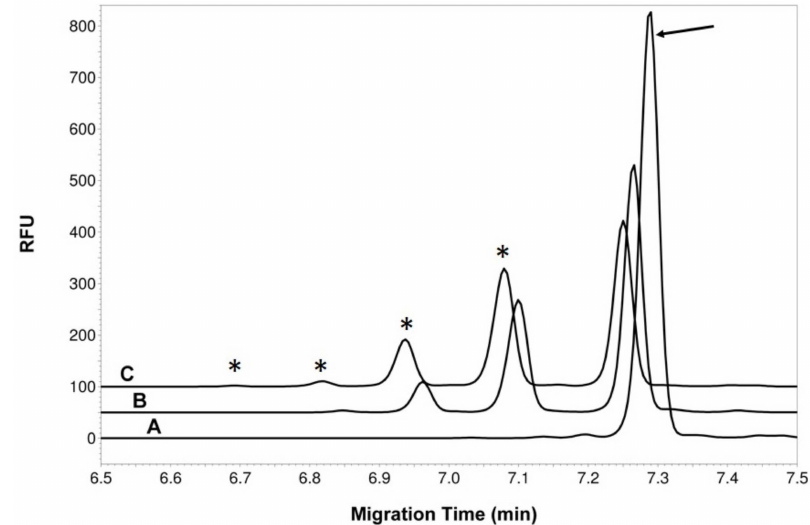
Figure 3. Capillary electrophoresis (CE) analysis of the MalE-SgtA reaction products. Electropherogram A is the acceptor alone (SML3 peptide labeled with FITC-Ahx, peak indicated by arrow) incubated for 24 h in presence of MalE-SgtA but without donor. Electropherogram B shows the complete reaction mix after 1 h incubation. Electropherogram C shows the complete reaction mix after 24 h incubation. The “*” indicates product peaks with added GlcNAc residue. The traces are shifted by 0.2 min to facilitate viewing of the